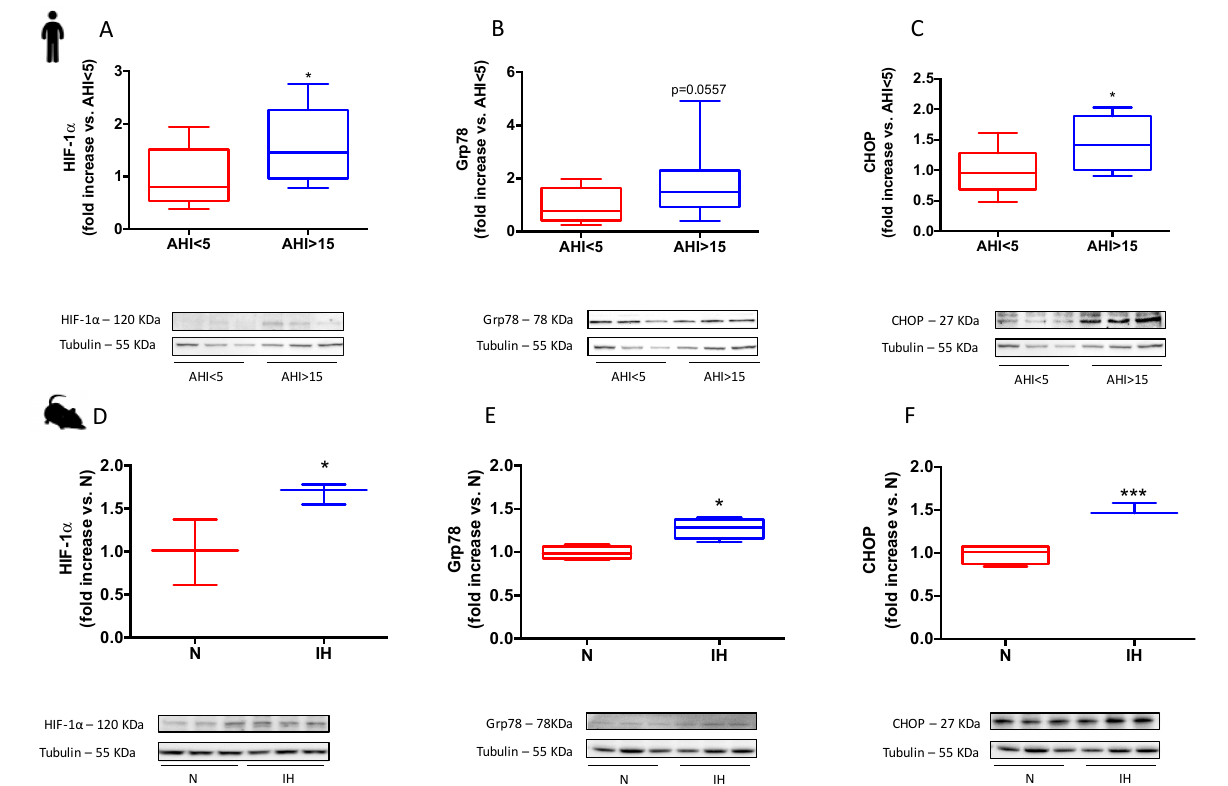
Figure 2. HIF-1 and ER stress in humans and mice under IH. Hypoxia inducible factor-1 α (HIF-1 α ), glucose regulated protein-78 KDalton (Grp78) and C/EBP homologous protein (CHOP, copyright from Moulin S. et al., Can. J. Cardiol, 2020) expression relative to Tubulin. Patients were stratified in quartiles of AHI (n = 10 each), and lowest and highest quartiles were compared. Quantification and representative images for HIF-1 α ( A ), Grp78 ( B ), and CHOP ( C ), in patients, respectively; quantification and representative images for HIF-1 α ( D ), Grp78 ( E ), and CHOP ( F ), in mice, respectively. Data are expressed in median and min to max values and analyzed using t-test; * p < 0.05, *** p < 0.001.